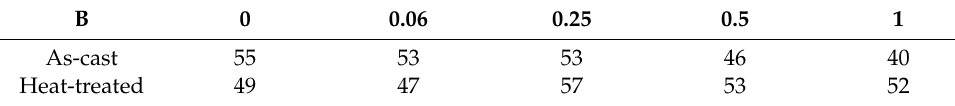
Table 3. HCP volume fractions in the alloys before wear testing.